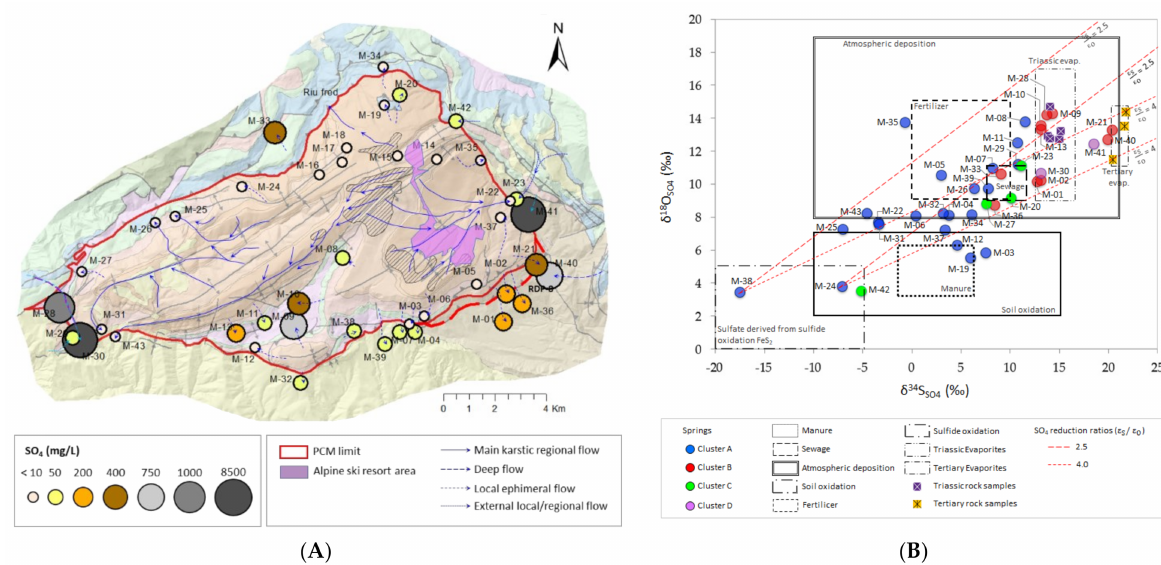
Figure 9. ( A ) Map of sulfate dissolved in GW. The values correspond to the averaged concentration for all the GW sampling campaigns conducted during the period September 2013–October 2015. ( B ) Dual isotope scatterplot using δ 18 O SO4 and δ 34 S SO4 . The areas of sulfates are derived from (1) sulfide oxidation [99]; (2) manure [100]; (3) soil [101]; (4) atmospheric deposition [102]; (5) fertilizers [103]; (6) sewage [104]; (7) Triassic evaporites [105]; and (8) Tertiary evaporites [106]. The long and short dashed red lines define the isotopic fractionation range ( ε 34 S/ ε 18 O SO4 ) in SO 4 reduction reactions, varying between 2.5 and 4, respectively